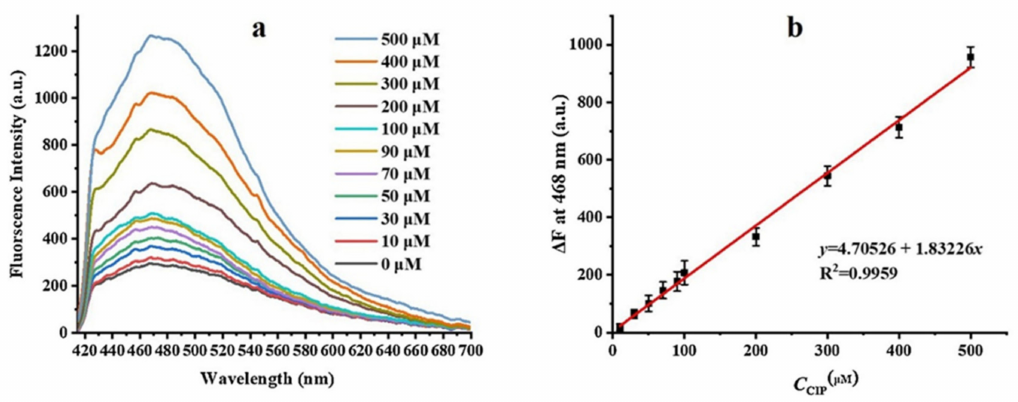
Figure 12. ( a ) Fluorescence response of MINs@PEGDA sensor for different concentrations of ciprofloxacin solutions, and ( b ) linear relationship between fluorescence intensity at 468 nm and CIP concentration. Reprinted with permission from Ref. [83]. Copyright 2021 Elsevier.